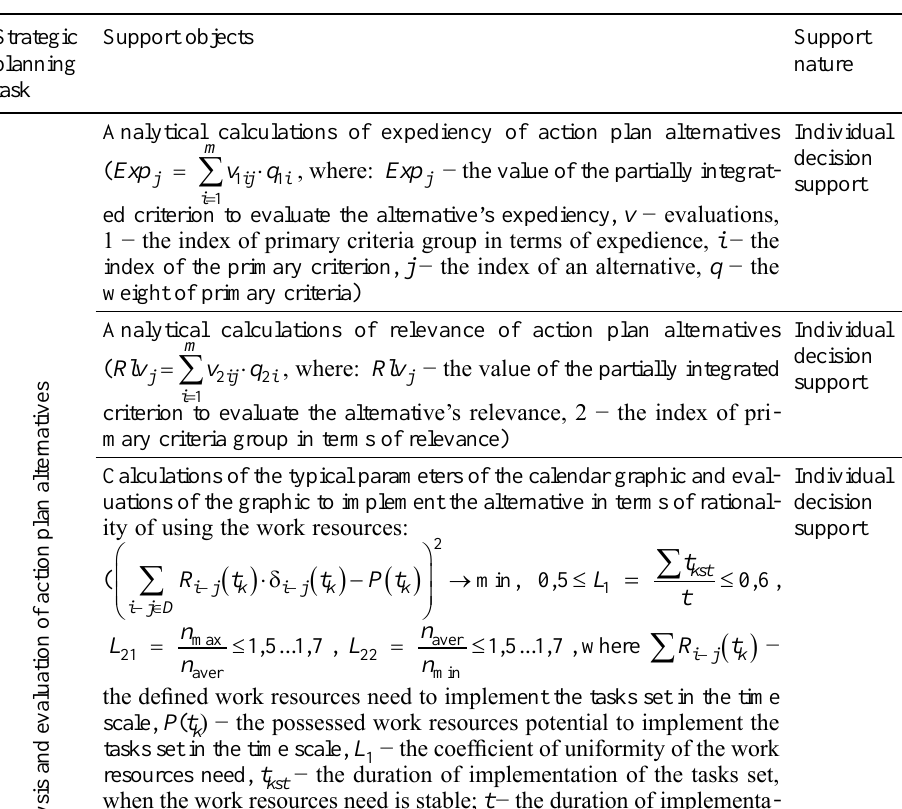
Table 3. The specification of intelligent support for the analysis and